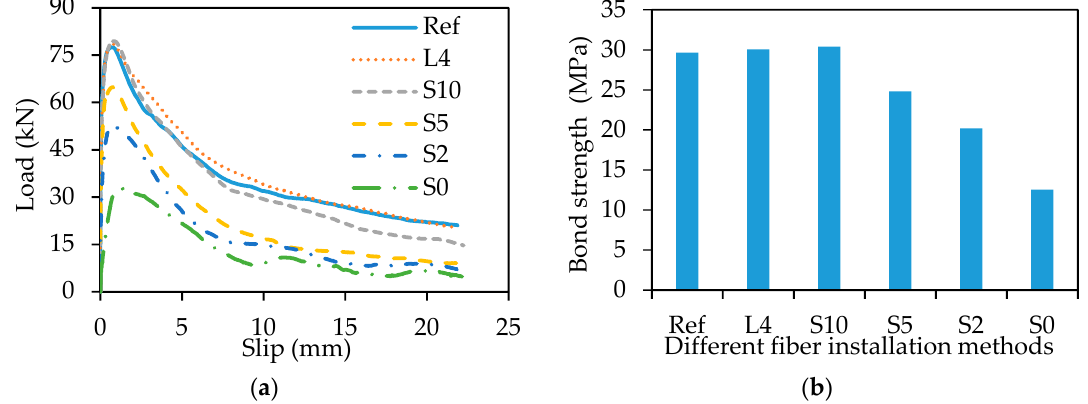
Figure 6. Pull-out test result: ( a ) load-slip curves; ( b ) bond strength.